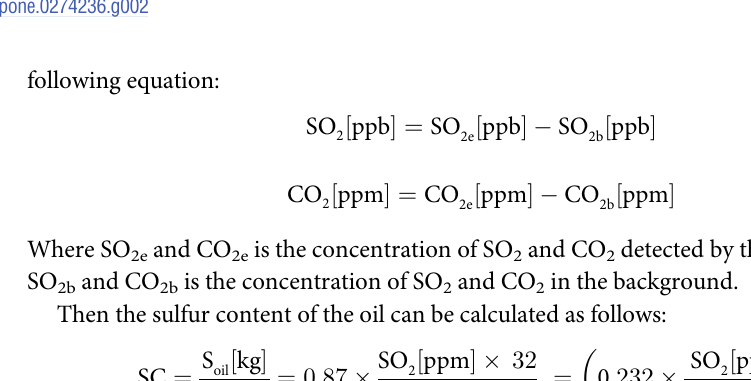
Fig 2. Schematic theory of sniffing method(the shadow represent the distribution of the ship plumes).